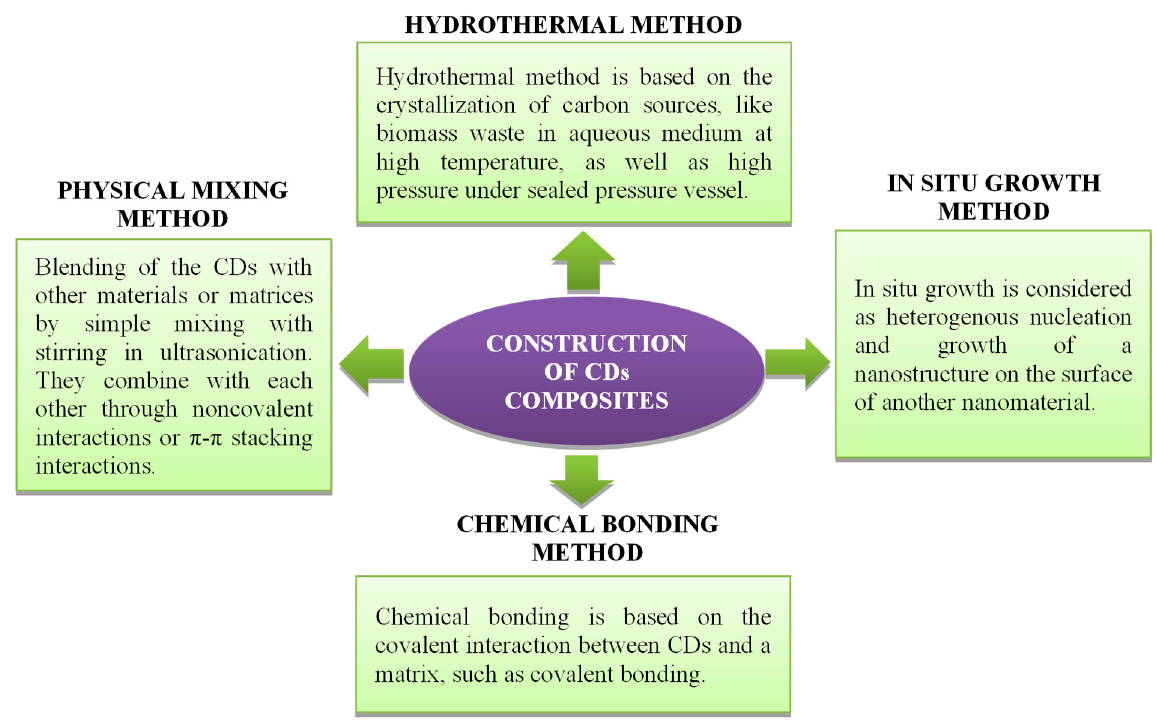
Figure 11. Synthesis of metal-based CDs composite.